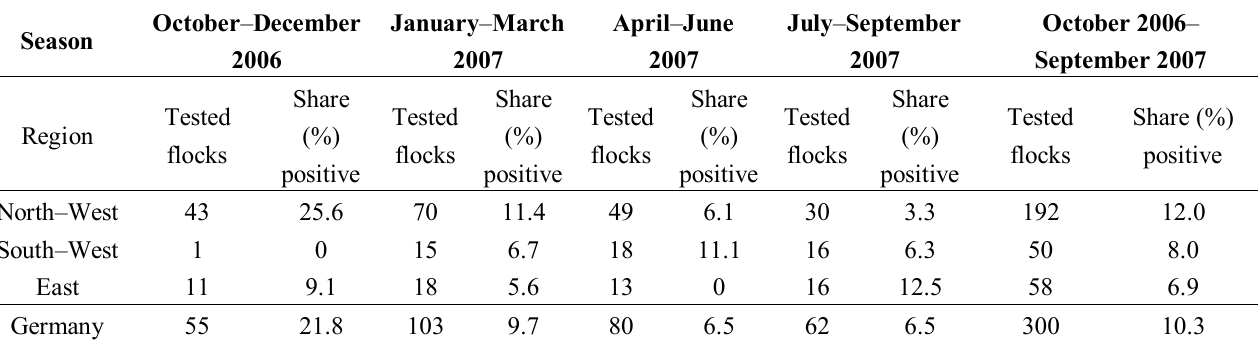
Table 6. Salmonella prevalence in turkey fattening flocks by region and season. Number of flocks tested and share positive flocks by season and region.